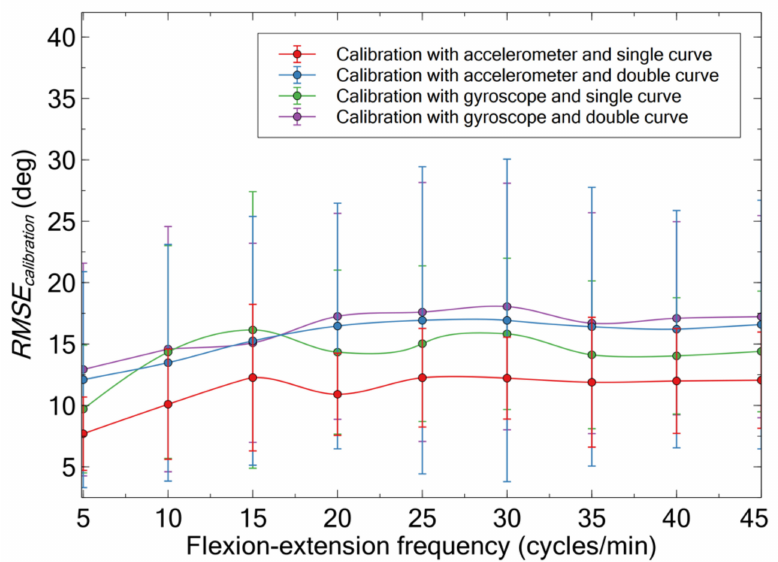
Figure 4. Comparison of the accuracy of the different strategies of calibration of the capacitive sensors, as quantified by the root mean square error between each calibrated signal and the stereophotogram- metry signal, for cyclic flexion-extensions at different frequencies. Each data point is originated by the average among 10 volunteers, considering two repetitions for each volunteer. The error bars represent the standard